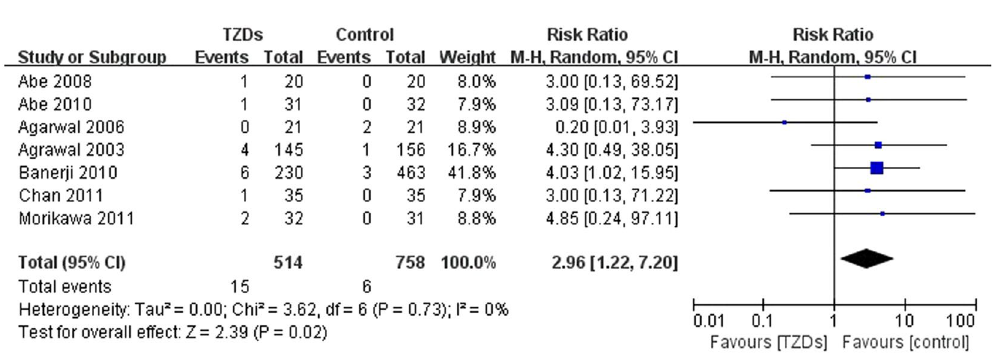
Figure 6. Risk of edema in patients with diabetes mellitus and renal impairment for the TZDs versus control groups from